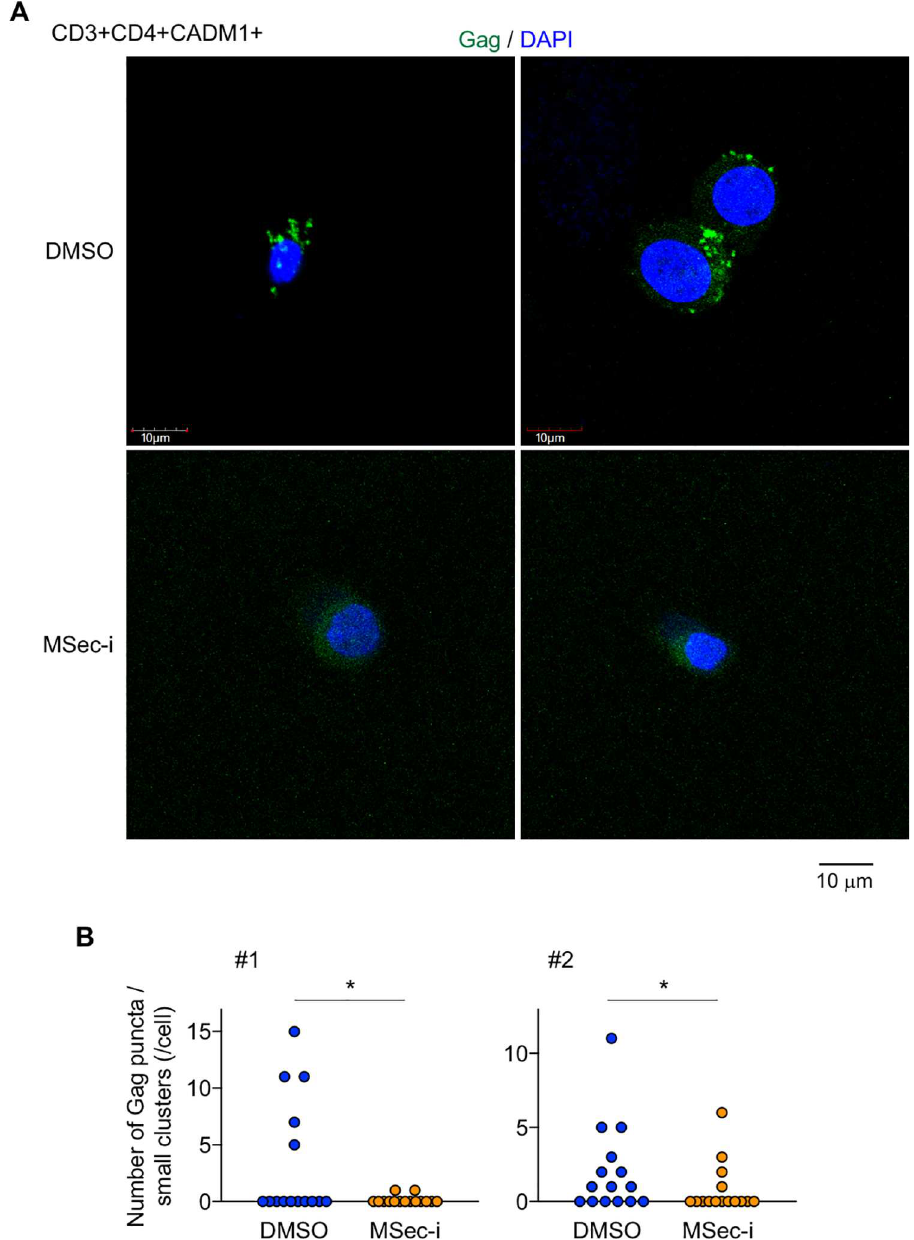
Fig 9. Effect of M-Sec inhibition on the intracellular distribution of Gag in CD3 + CD4 + CADM1 + T cells of HTLV- 1 carriers. ( A ) The CD3 + CD4 + CADM1 + cells in the live cell gate were sorted from PBMCs of an HTLV-1 carrier, cultured with vehicle (DMSO, upper panels) or M-Sec inhibitor (MSec-i, lower panels) for 3 days, and analyzed for Gag (green). The nuclei were also stained with DAPI (blue). Scale bar: 10 μ m. ( B ) The sorted CD3 + CD4 + CADM1 + cells of HTLV-1 carriers (#1 and #2) were analyzed as in ( A ). The numbers of puncta or small clusters of Gag per cell are shown (16 cells for each). � p < 0.05. CADM1 + T cells of HTLV-1 carriers were analyzed, the number of puncta or small clusters of Gag per cell in M-Sec inhibitor-treated cultures was lower than that of the control cultures (Fig 9A and 9B).